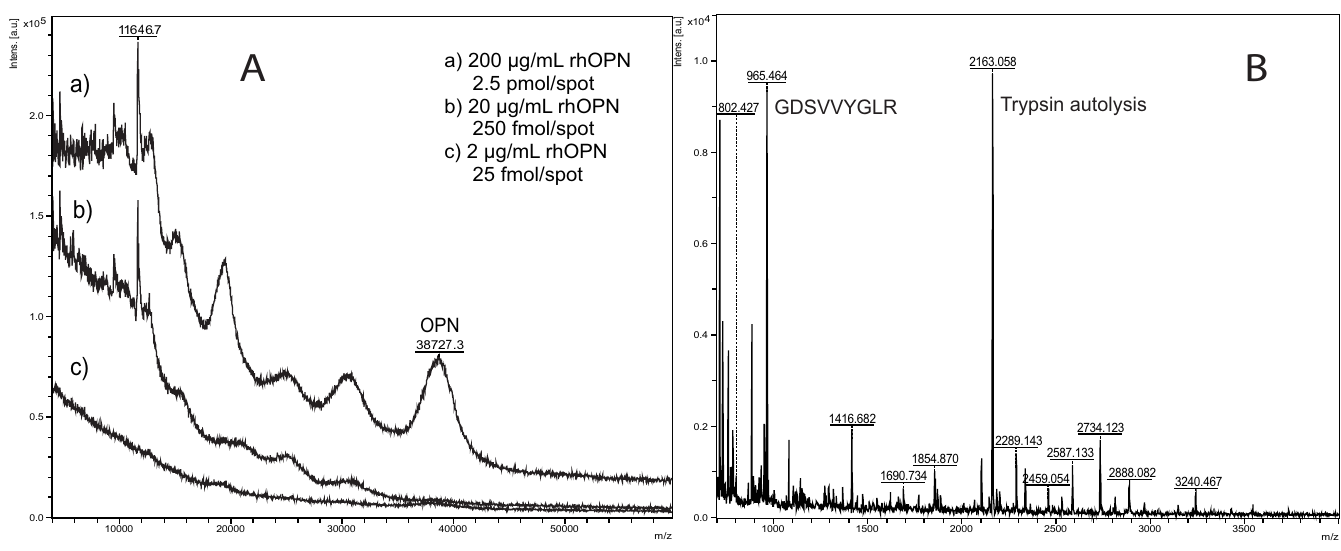
Fig 2. MALDI-MS of rhOPN. (A) Intact rhOPN. (B) Trypsin digest of 100 ng/mL rhOPN.